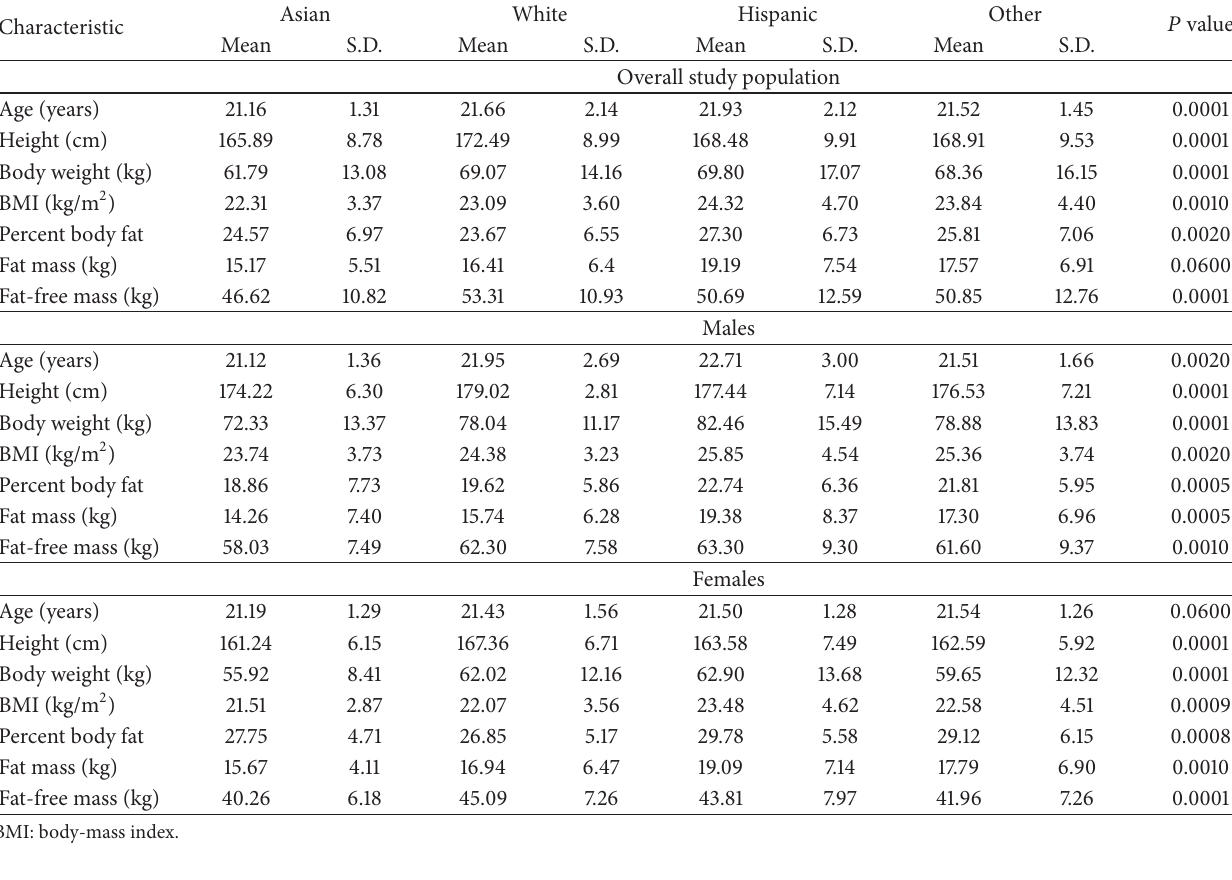
Table 2: Study population characteristics according to race/ethnicity and according to race/ethnicity and gender. Characteristic